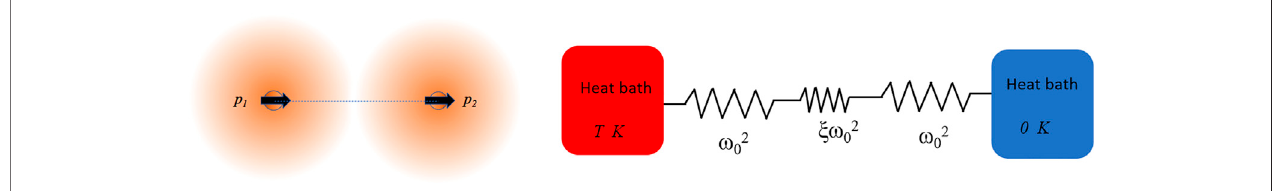
FIGURE 1 | Schematic showing the two systems which are being related: two dipoles p 1 and p 2 which are interacting with their near- fi eld; and two harmonic oscillatorswithnaturalfrequencies ω 0 exchangingenergywiththeirrespectiveheatbathsatdifferenttemperatures T K and0 K andwhicharecoupledtoeachotherwith spring constant ξω 2 0